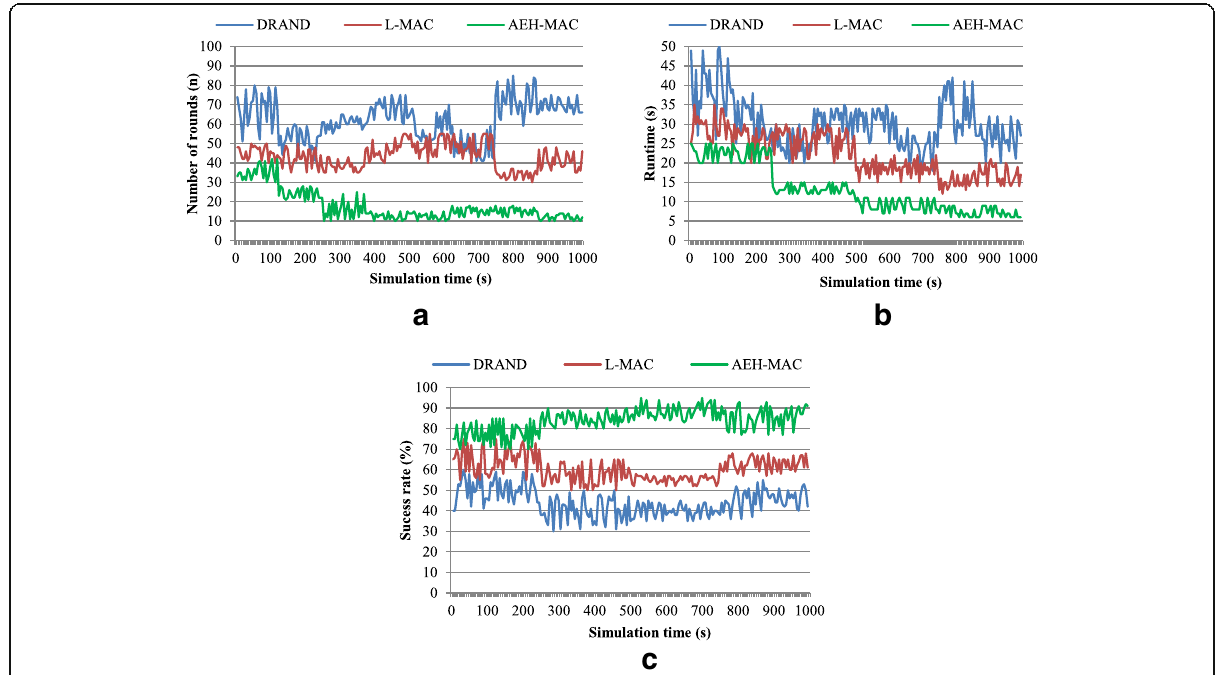
Fig. 14 Multi-hop Scenario for variable bit rate: ( a ) Simulation time vs. Rounds ( b ) Simulation Time vs. Runtime ( c ) Simulation time vs. Success